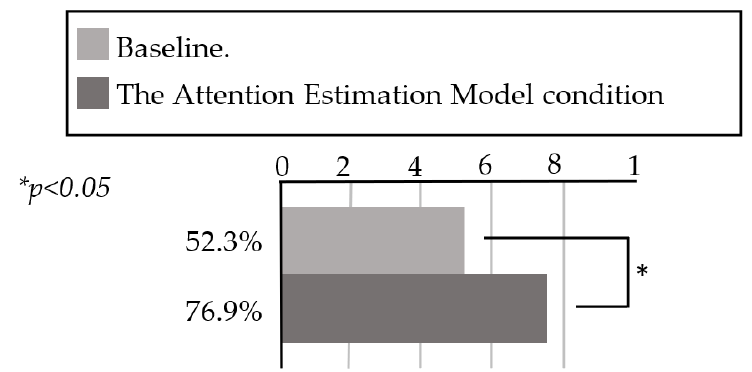
Figure 5. Groups of customers who responded to the robot after it greeted them under two conditions.